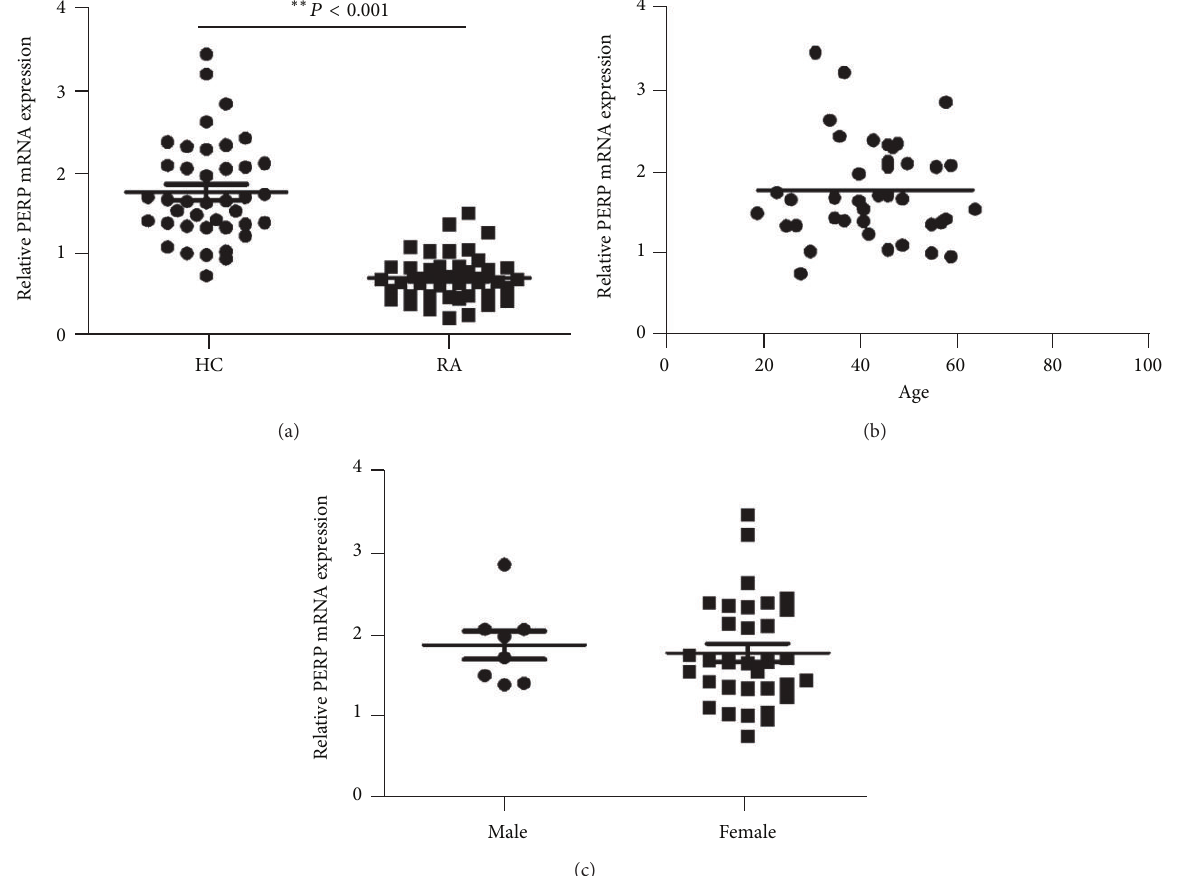
Figure 1: Decreased expression of PERP in peripheral blood lymphocytes (PBMCs) from patients with rheumatoid arthritis (RA) and PERP expression levels in age and sex in healthy controls (HCs) have no differences. (a) Expression of PERP mRNA in PBMCs from RA patients ( 𝑛 = 40 ) and healthy controls (HCs; 𝑛 = 40 ) ( 𝑃 < 0.05 ). (b) The correlation between age and PERP expression levels in healthy control (HCs; 𝑛 = 40 ) ( 𝑃 > 0.05 ). (c) The expression levels of Perp between male and female in healthy control (HCs; 𝑛 = 40 ) ( 𝑃 > 0.05 ). 𝑃 value was determined by Mann-Whitney test. 𝑃 < 0.05 deems significantly